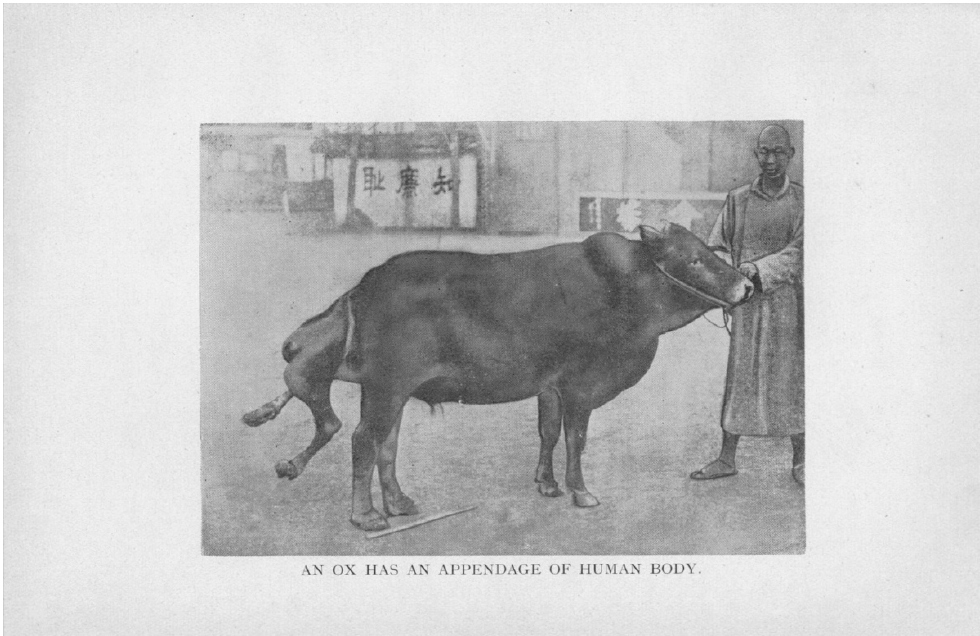
Figure 5. A photo of an ox with a human body part. Source: An Outline of Karma , 1940. Religions 2019 , 10 , x FOR PEER REVIEW